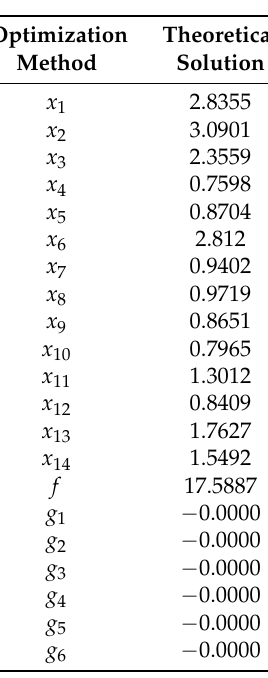
Table 2. Results of the mathematical